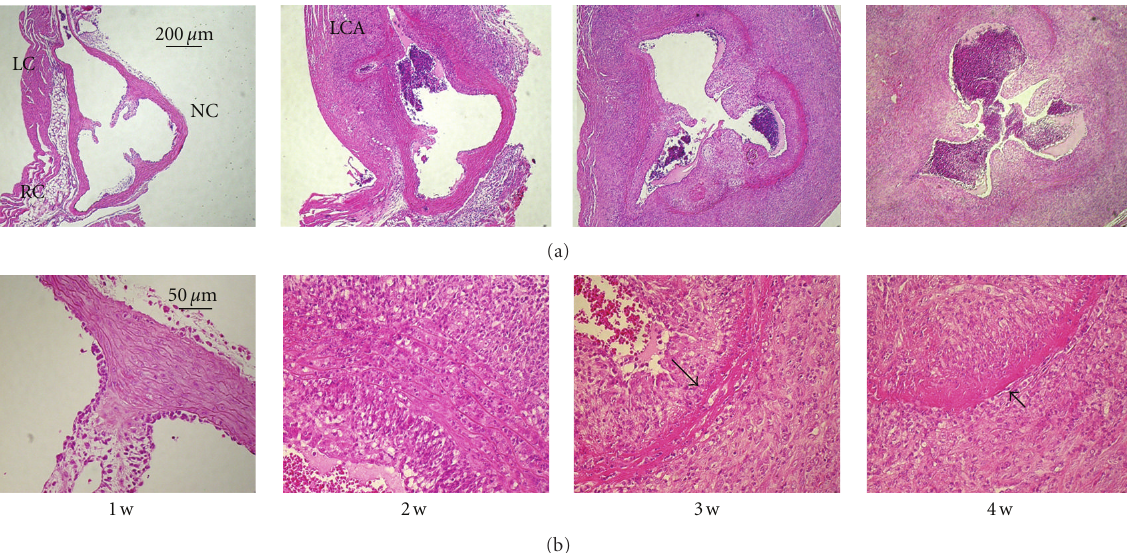
Figure 2: CAWS arteritis development and progress in DBA/2 mice. Cardiovascular tissue was sampled every week after CAWS administration, and induced aortitis was observed with an incidence of 100%. The first week panel (a, b—1w) shows slight aortic valve thickening and endocardial inflammation of the Valsalva sinuses; left coronary (LC) sinus, right coronary (RC) sinus, and noncoronary (NC) sinus. The second week panel (a, b—2w) shows expansion of the severe inflammatory lesion around the left coronary arteries (LCA). The third and fourth week panels (a, b—3w and 4w) show the features of the necrosis-related vasculitis. Inflammatory cells have spread to all the layers and sinuses with fibrinoid necrosis in the elastic lamina (arrows). Severe stenosis was found in coronary arteries because of inflammatory cells accumulation.